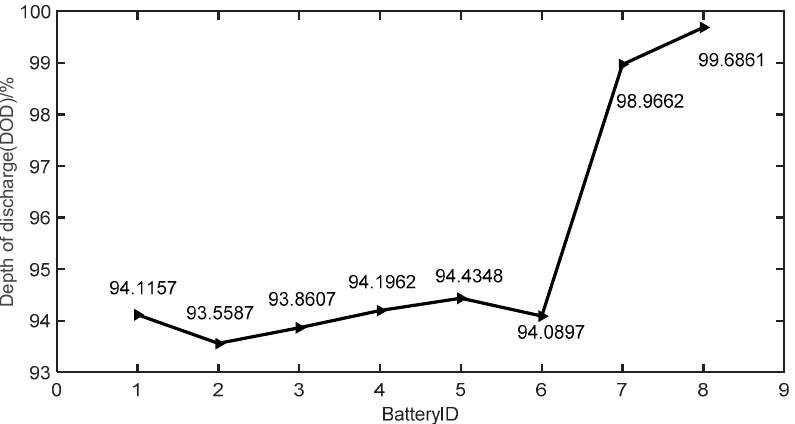
Figure 9. The depth of discharge (DOD) of batteries under the low temperature and room temperature conditions.